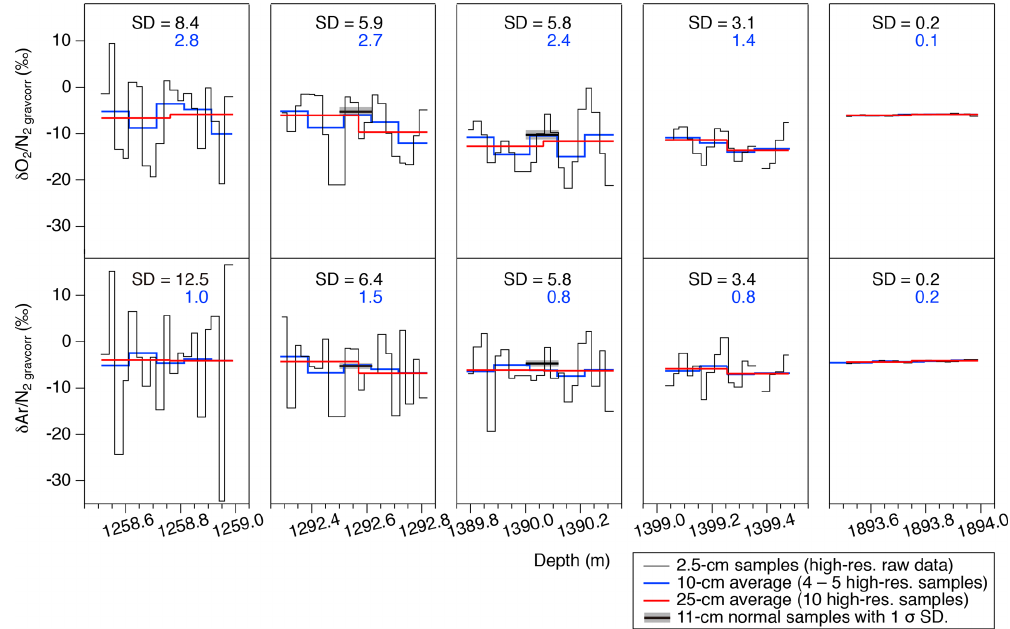
Figure 6. High-resolution data of δ O 2 / N 2gravcorr and δ Ar / N 2gravcorr in five depth intervals. Black, blue, and red lines are the raw data (2.5cm resolution), 10cm averages, and 25cm averages, respectively. Standard deviations (SDs) of the raw 2.5cm data (black) and 10cm averages (blue) are shown in each panel. Thick horizontal black bars with gray shadings in some panels are the independent data from the 11cm samples with 1 σ error (measured by the standard